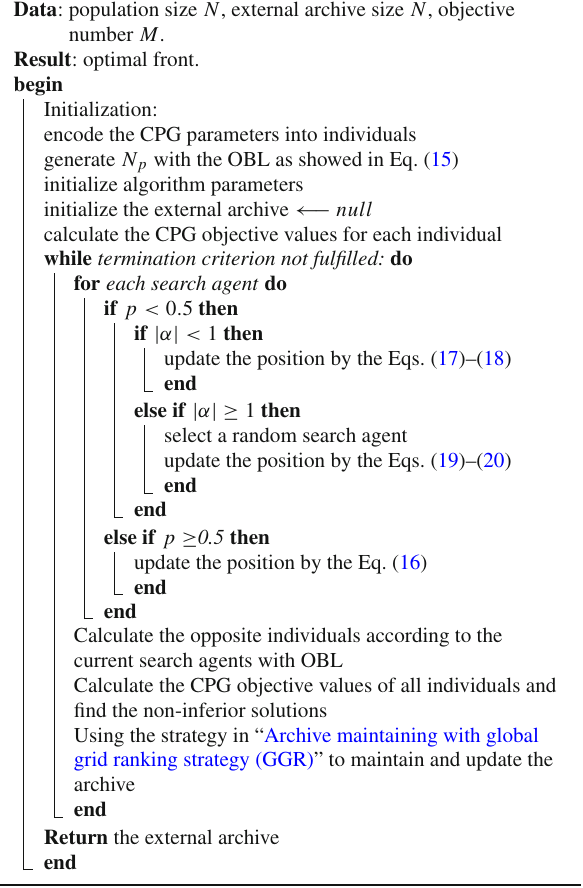
Algorithm 1: Evolving the CPG network of biomimetic robotic fish with